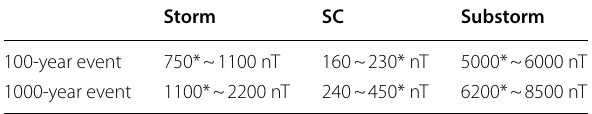
Asterisks denote the probable values from the better fitted distributions